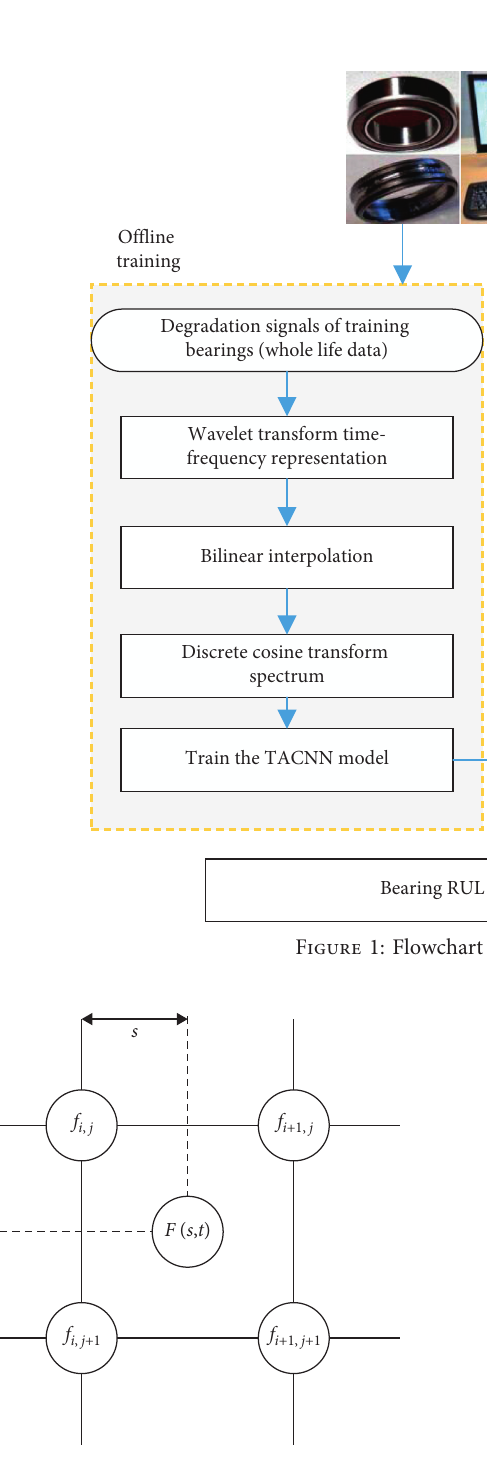
Figure 2: Pixel arrangement of bilinear